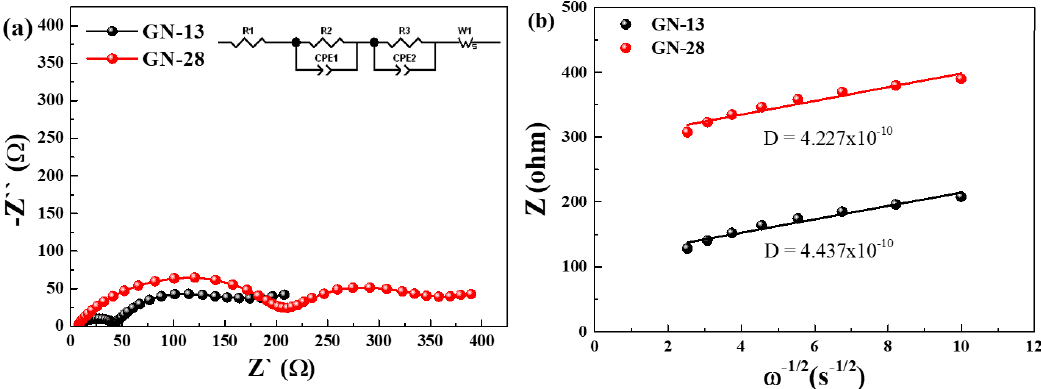
Figure 7. ( a ) Electrochemical impedance spectra (EIS) (Nyquist plots), inset: EIS fit by the equivalent − 1 / 2 at low circuit and ( b ) the relationship lines between Z’ vs. ω − 1/2 at low frequency. circuit and ( b ) the relationship lines between Z’ vs. ω